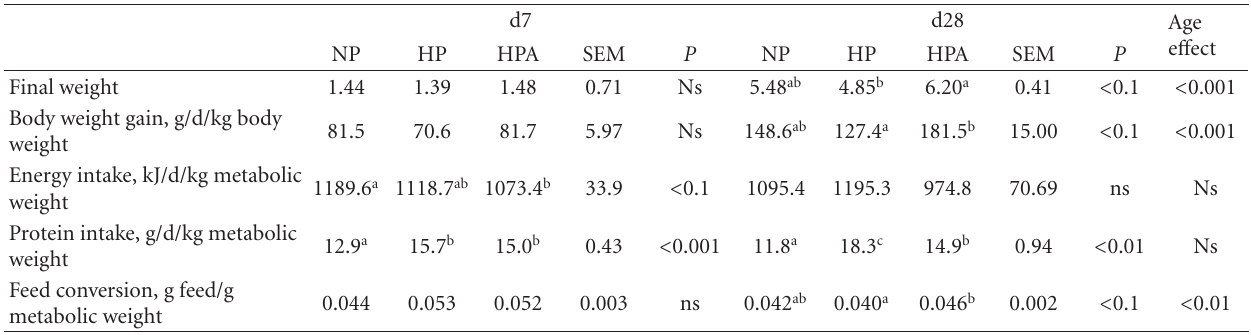
Table 3: Growth performance of piglets fed NP, HP and HPA diets at d7 and d28.